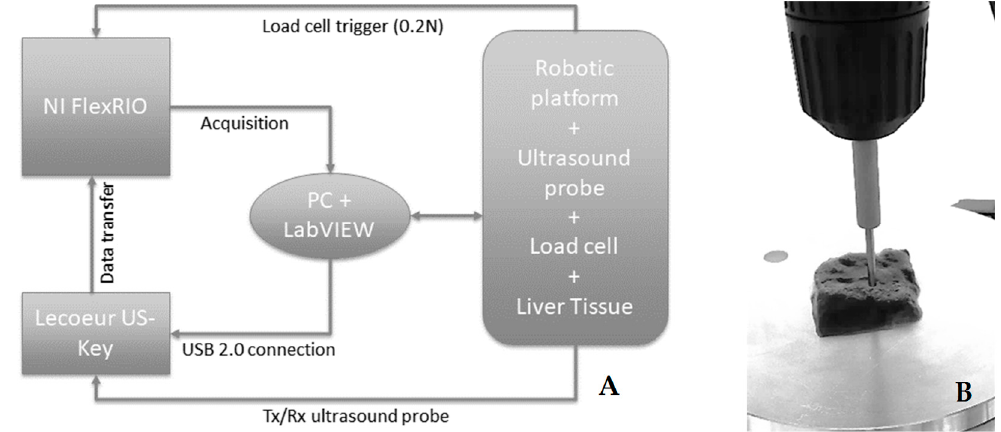
Figure 1. Block scheme of the experimental setup ( A ). Zoom on the ultrasonic needle probe (16 MHz central frequency, 3 mm external diameter) in contact with a liver sample integrated with the holder of the load cell for tactile sensing ( B ).